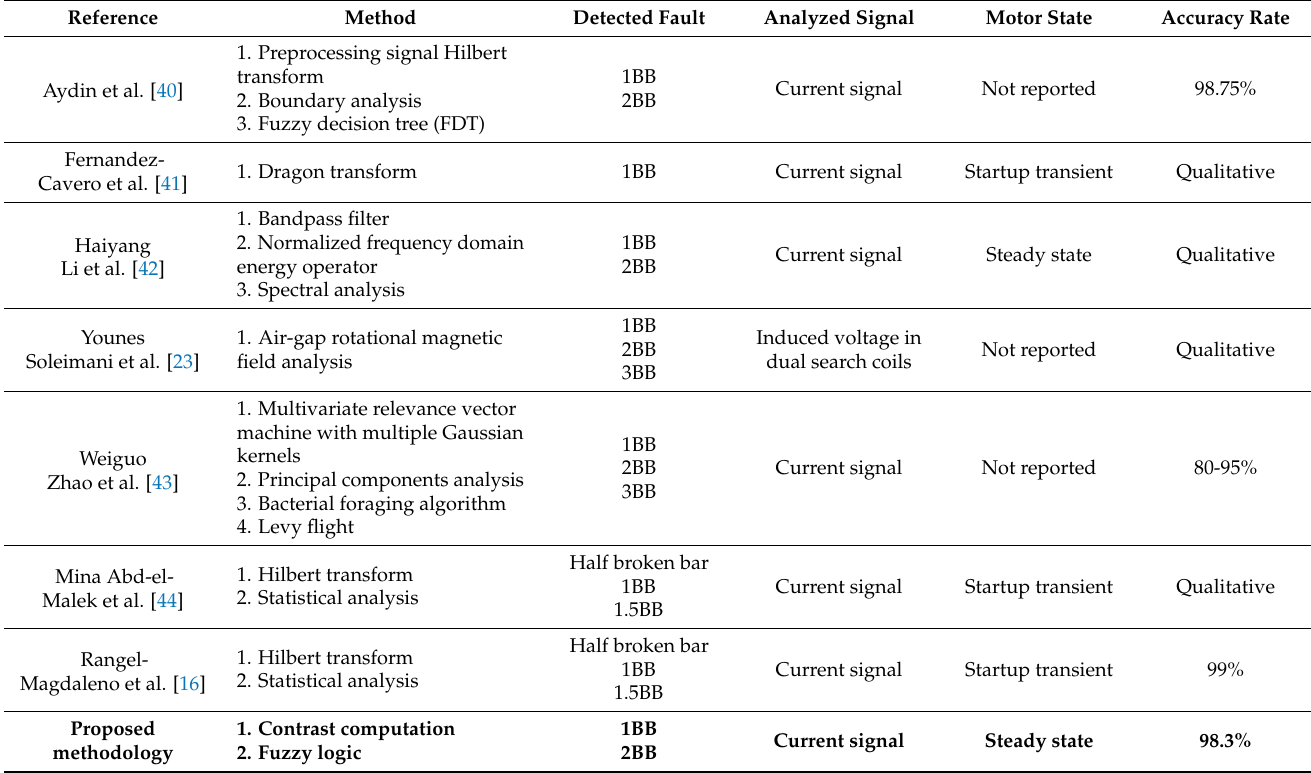
Table 4. Proposed methodology performance